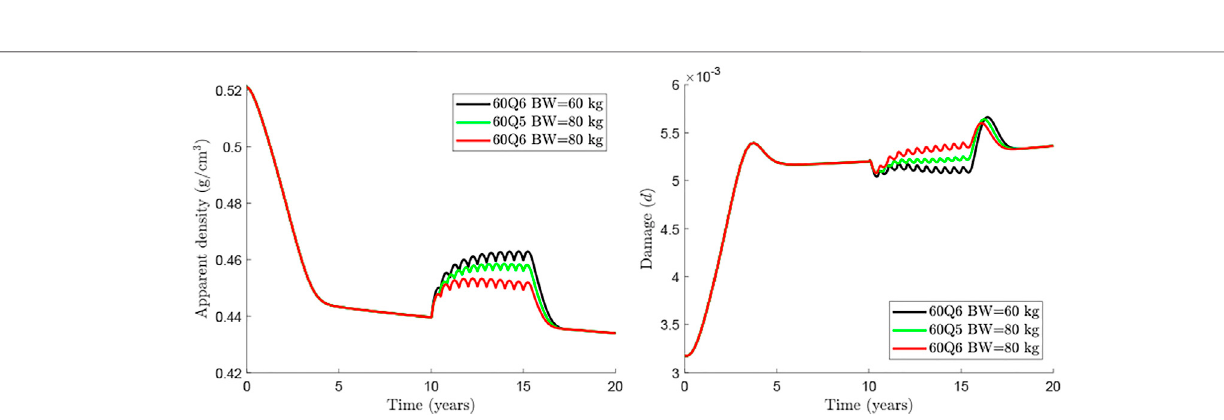
Frontiers in Bioengineering and Biotechnology |